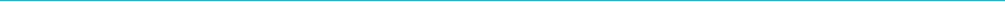
Figure 5: Univariate correlations of insurer outcome data with patient, trauma, treatment and hospital outcome variables for survivors of trau- ma.*** p <0.001, ** p<0.01, * p <0.05; the power of the statistical interrelation (r) is illustrated by the intensity of the particular colour used: red for negative and blue for positive correlations.AIS = Abbreviated Injury Scale score; BP = blood pressure; GCS = Glasgow Coma Scale score; GOS = Glasgow Outcome Scale score ICU = intensive care unit; MGAP = mechanism, Glasgow Coma Scale score age and arterial pressure; LEP total = mean nursing workload per patient during hospital stay; LOS = length of hospital stay; (N)ISS = (New) Injury Severity Score; PRCW = percentage incapacity for work; RISC2 = Revised Injury Severity Classification 2 (%); SaO 2 = oxygen saturation